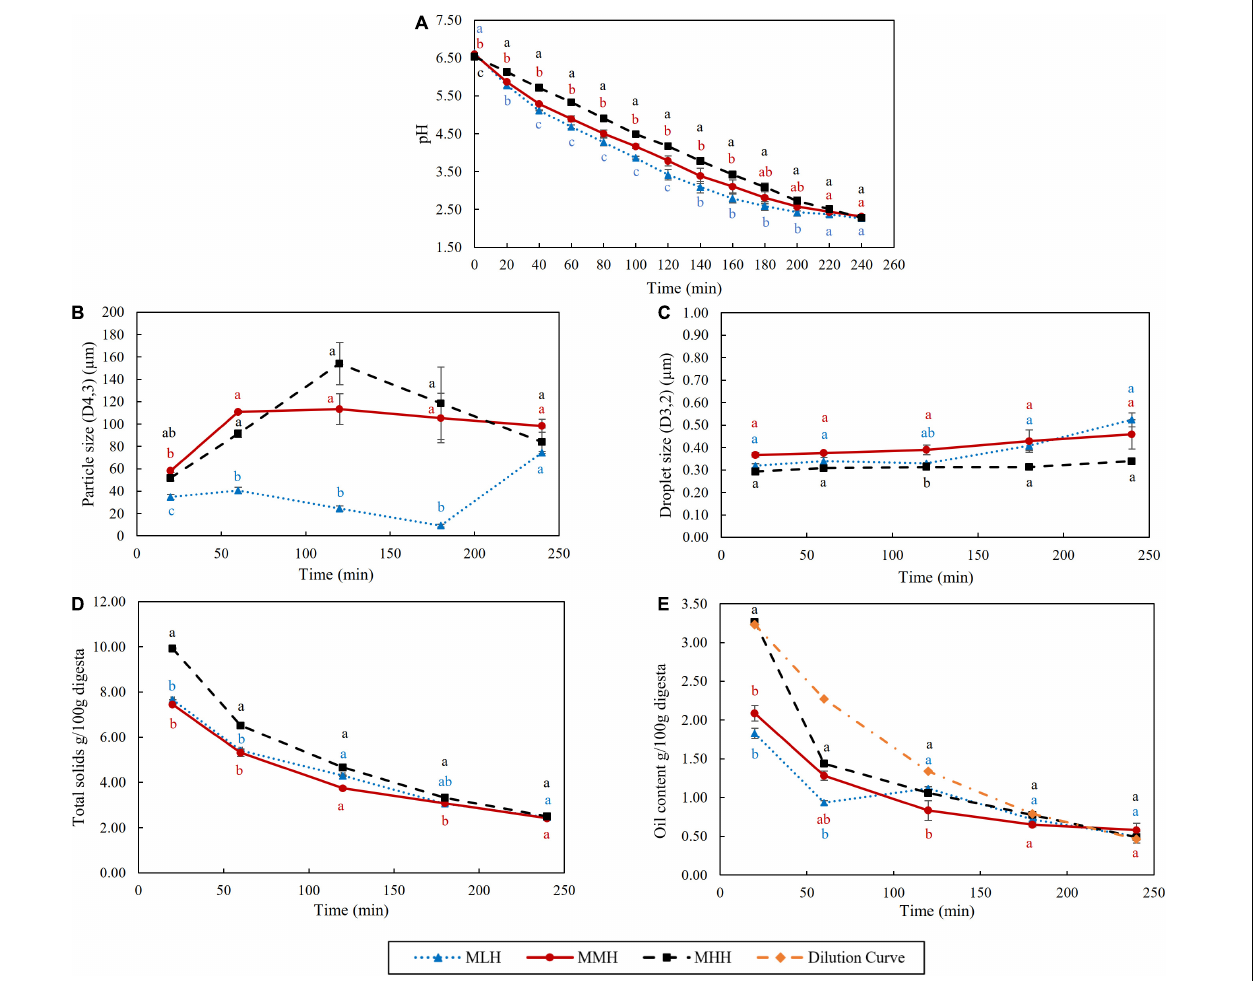
FIGURE 3 | Effect of dynamic in vitro gastric digestion of different recombined milk systems on changes in (A) pH, (B) particle size ( D 4 , 3 ), (C) oil droplet size ( D 3 , 2 ), (D) total solids and (E) oil content of the emptied gastric digesta. The standard error is indicated by error